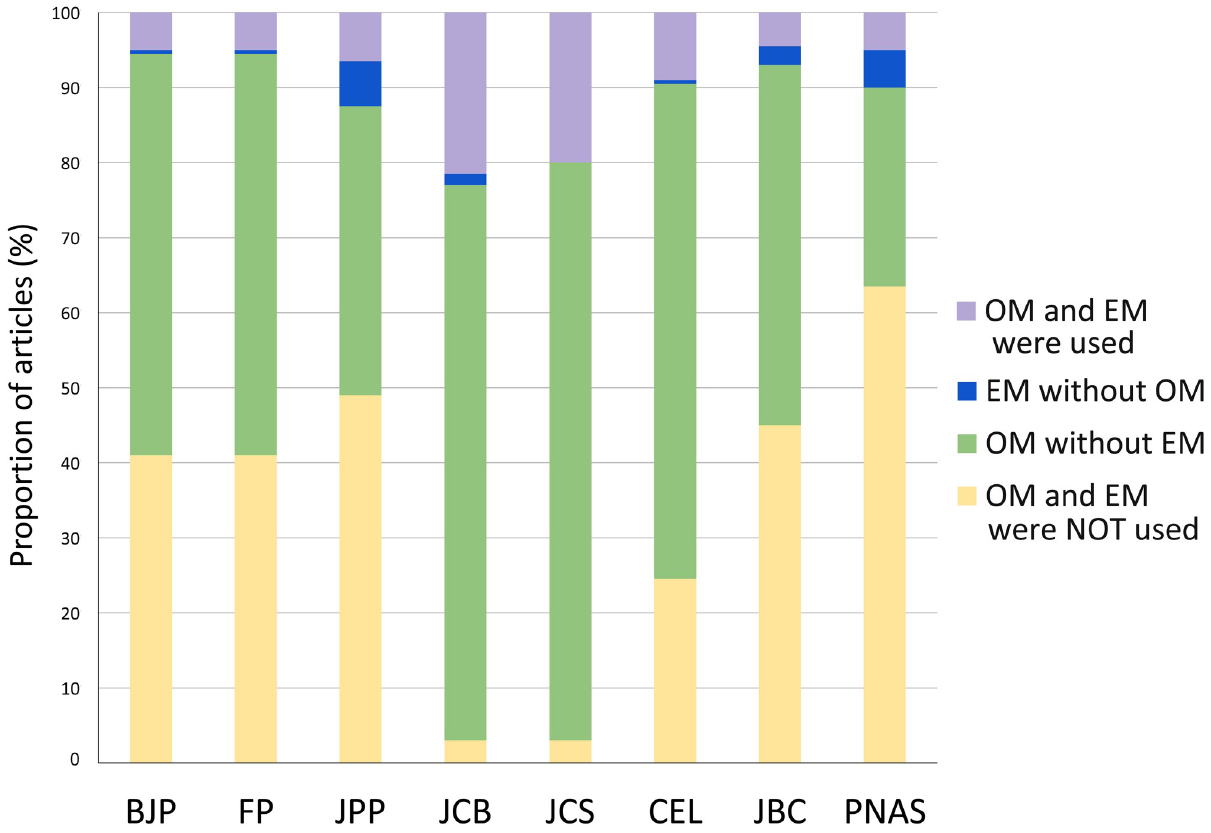
Fig 1. Comparative analysis of the proportion of articles that uses microscopy techniques in biomedical sciences journals. Analysis of the presence of optical (OM) and electron (EM) microscopy methodologies in all articles published in 2019 in the journals: British Journal of Pharmacology (BJP), Journal of Pharmacy and Pharmacology (JPP), Frontiers in Pharmacology (FP), Journal of Cell Biology (JCB), Journal of Cell Science (JCS), Cells (CEL), Journal of Biological Chemistry (JBC) and Proceedings of the National Academy of Sciences (PNAS). N = 200 articles analyzed in each scientific